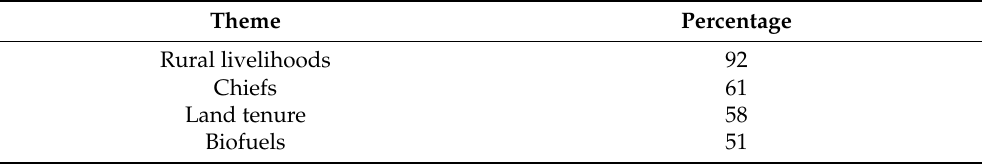
Table 3. The dominant themes from Nvivo